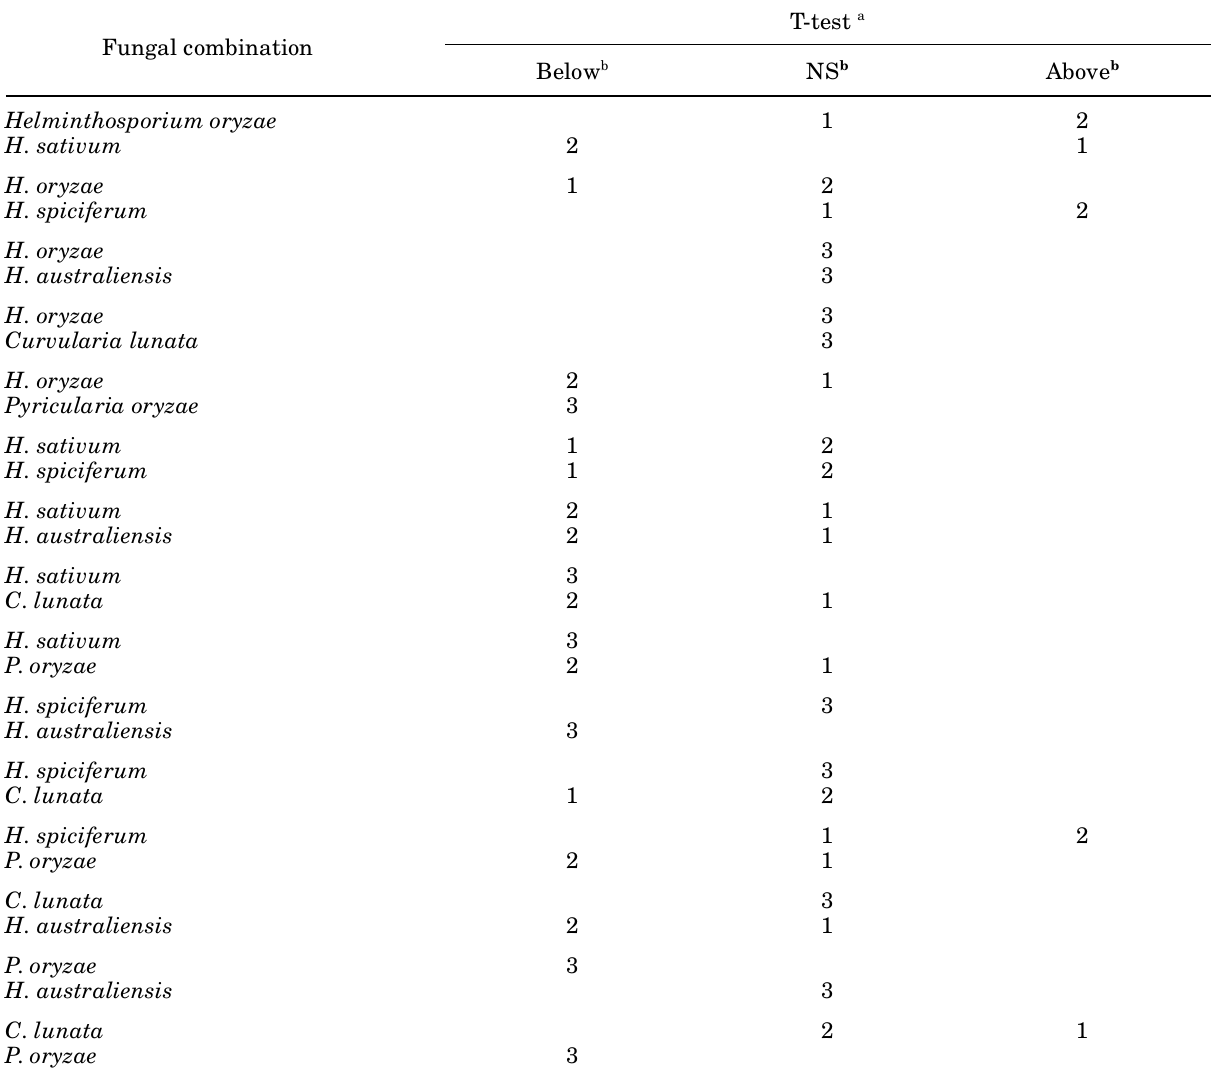
Table 1. Results of artificial inoculation on rice leaves of each fungus combined with one of the other five fungi in various proportions (25:75; 50:50; 75:25) comparing observed relative yield (RY) values of each species with expected values. T-test a Fungal combination Below b NS b Above b Helminthosporium oryzae 1